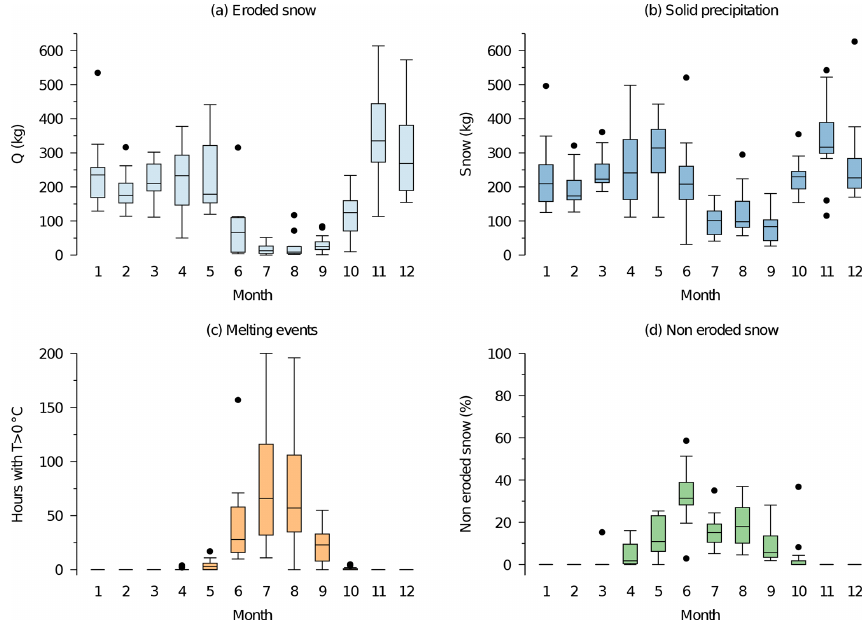
Figure 6. Box plots of monthly eroded snow (a) , monthly solid precipitation (b) , monthly number of hours with above-zero temperatures (c) and monthly fraction of conserved solid precipitation (d) , obtained for the period 1 October 2002–30 September 2015. The horizontal bar inside the box is drawn at the median, and the upper and lower ends of the box are drawn at the upper and lower quartile, respectively. The vertical lines, called whiskers, extend up to the most distant point that has a value within 1.5 times the interquartile range. The points outside these limits are drawn individually with dots.